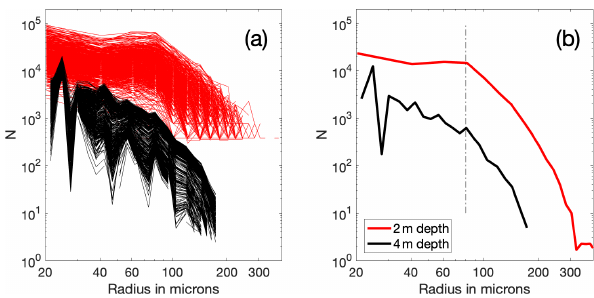
Figure A1. The number of bubbles per unit micrometre radius per unit volume ( N ) as a function of radius. (a) All camera (red) and resonator (black) 1s bubble size distributions for a single 45min camera measurement period. (b) The average of those distributions, including the artefact, which is the downward dip to the right of the plot. The dotted line at 80µm marks the slope break in the 2m distributions.